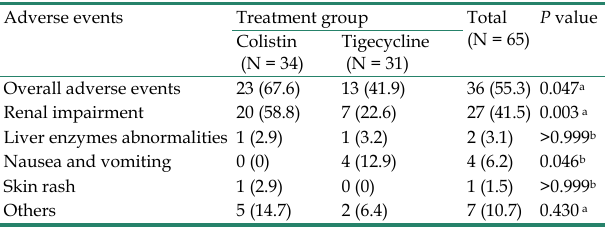
Figure 2. Chart flow with the distribution of all patients treated with A. baumannii complex osteomyelitis and those selected for the present study Table 2 . Comparison of incidence of adverse events during treatment for patients receiving colistin or tigecycline